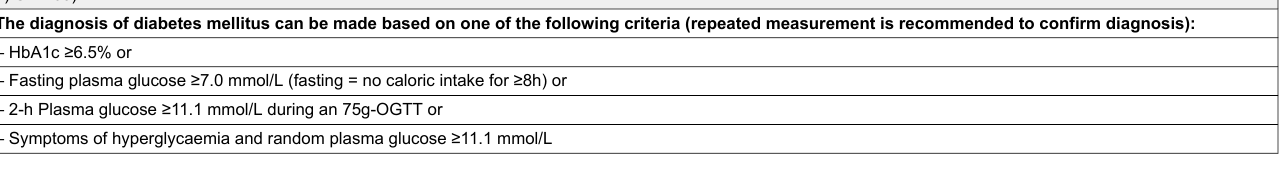
Table 2: Criteria for the diagnosis of prediabetes (adapted from American Diabetes A. Standards of medical care in diabetes – 2012. Diabetes Care. 2012;35(Suppl 1):S11–63). The diagnosis of prediabetes mellitus can be made based on one of the following criteria (repeated measurement is recommended to confirm diagnosis): – Fasting plasma glucose 5.6–6.9 mmol/L (impaired fasting glucose) or